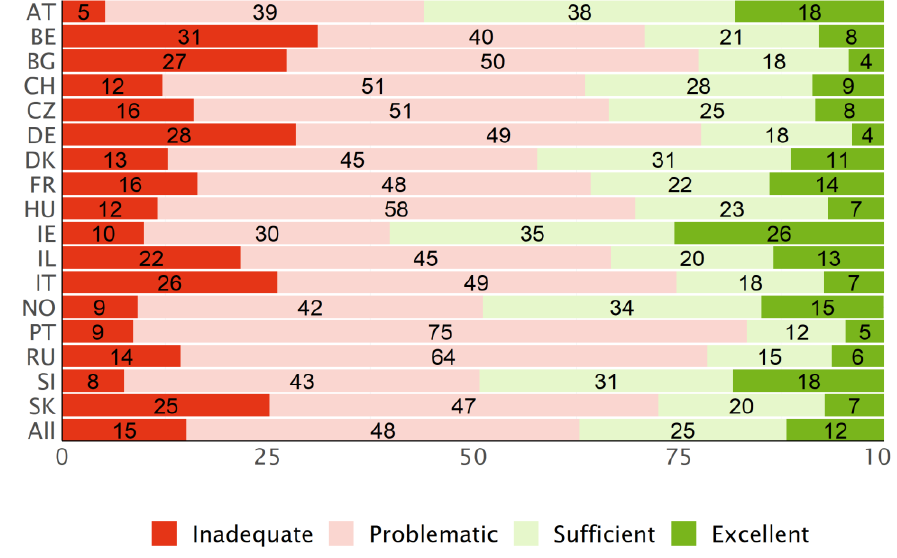
Figure 5. Distribution of the HLS 19 -Q12 levels for general HL, based on type P scores, for each country and the mean for all countries.